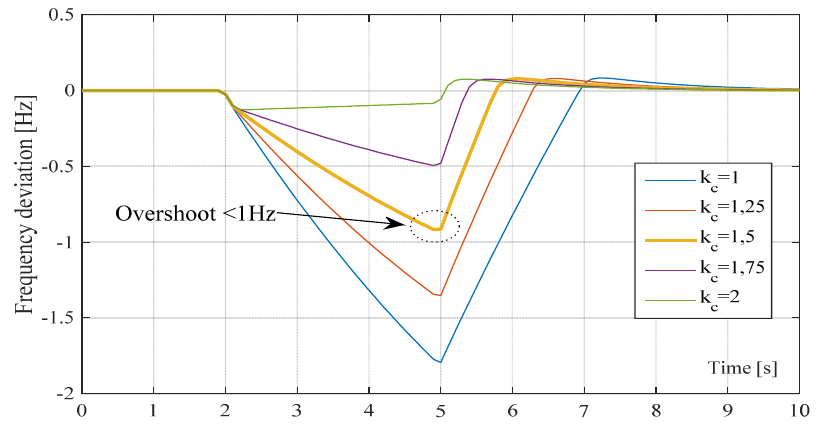
k . Figure 7. Determination of k c